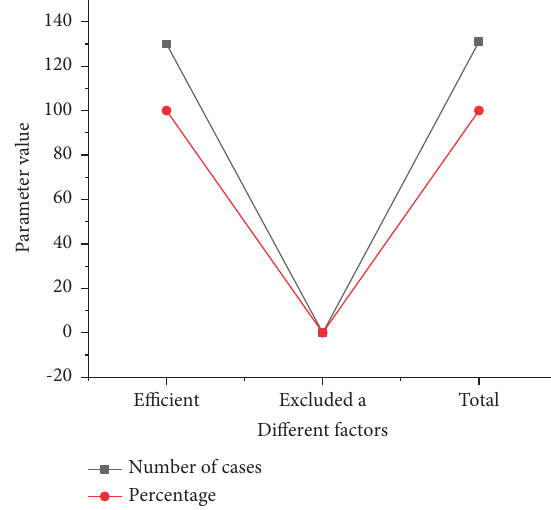
Figure 9: Data diagram of risk indicators for prefabricated building